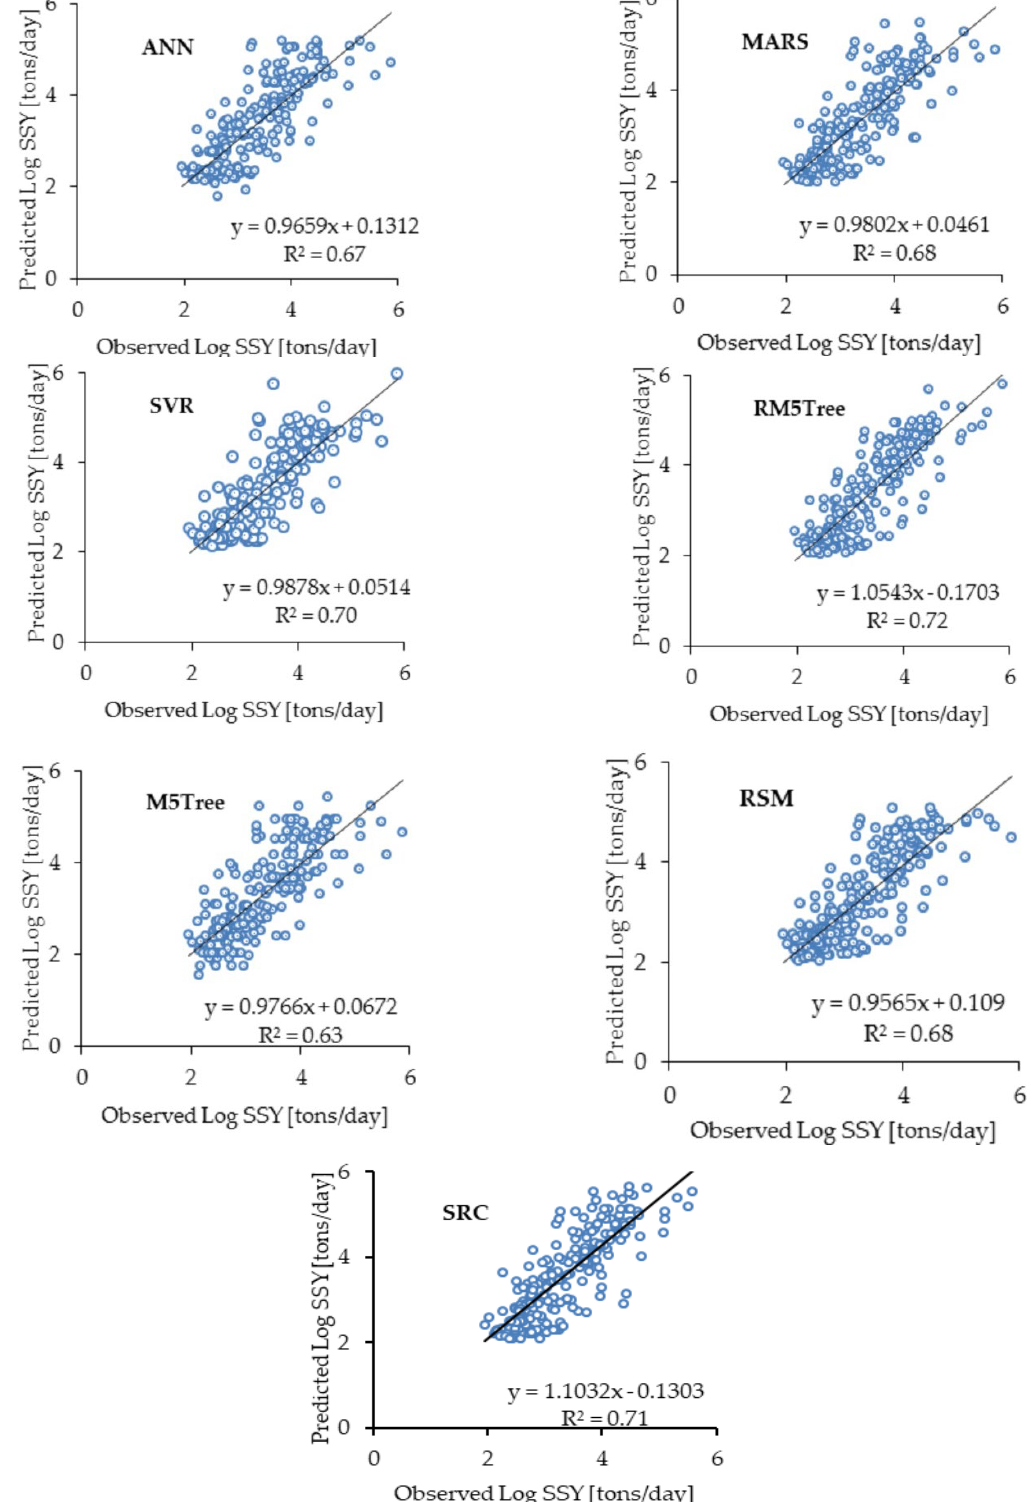
Figure 11. Scatter plots of the observed and predicted SSYs that were found using the ANN, MARS, SVR, M5Tree, RM5Tree, RSM and SRC models.